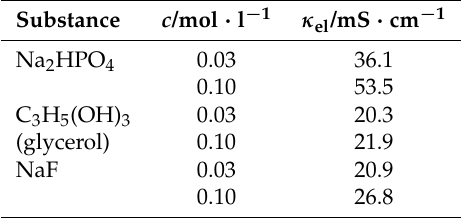
Table 3. Chemical composition, and conductivity κ el of the electrolytes for the experiments depicted in Figure 8; the pH of the electrolytes was adjusted by the addition of KOH solution up to pH = 13. Substance